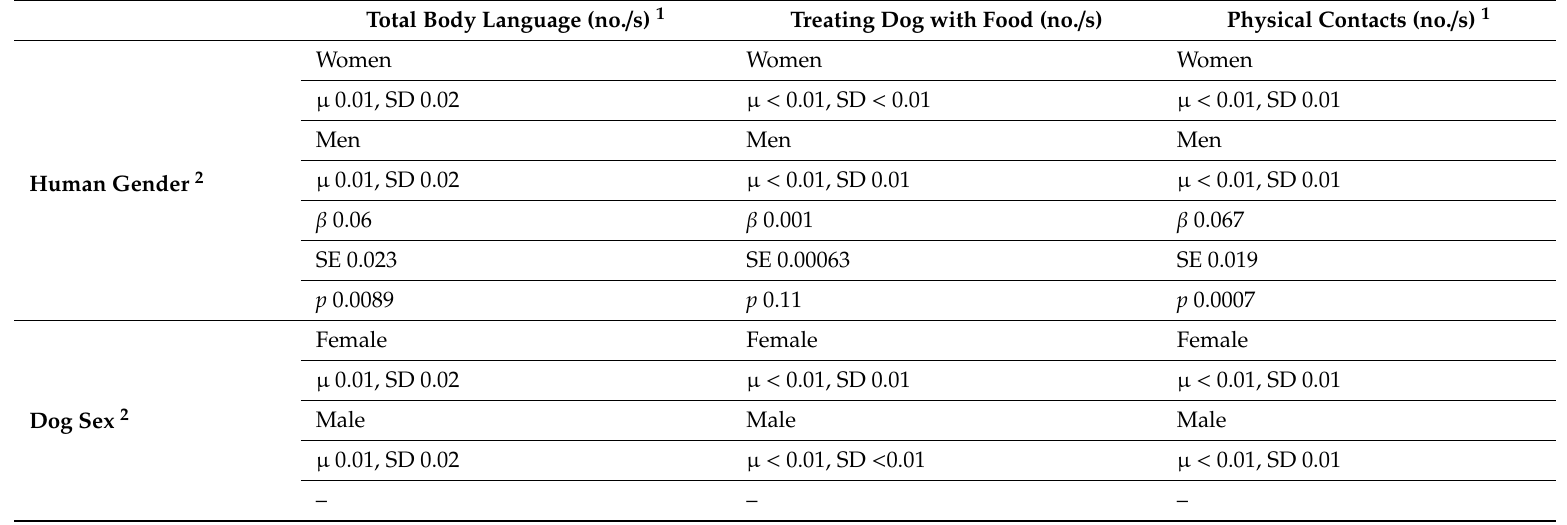
Table 9. Generalized linear mixed model of dog sex and human gender (independent variables) e ff ects on human body language (dependent variables). Mean ( µ ) and standard deviation (SD) of di ff erent dependent variables by gender / sex was provided. All body languages were analysed as frequencies (numbers of events / total walking